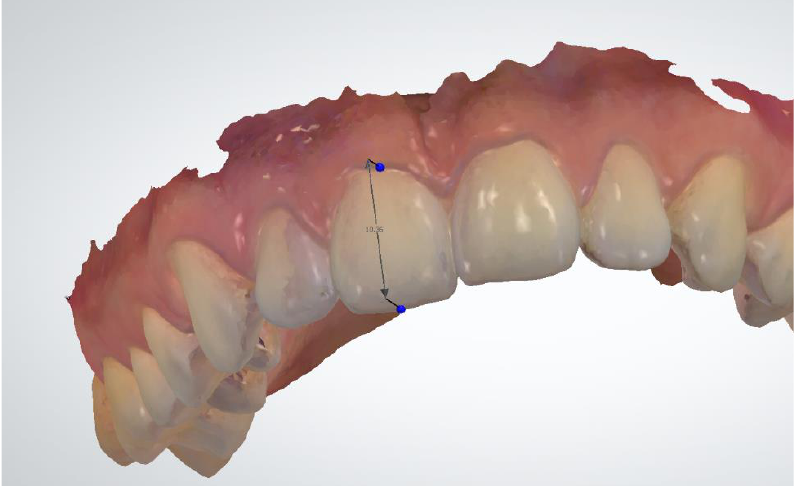
Figure 3. Mesial-distal width, OrthoAnalyzer.